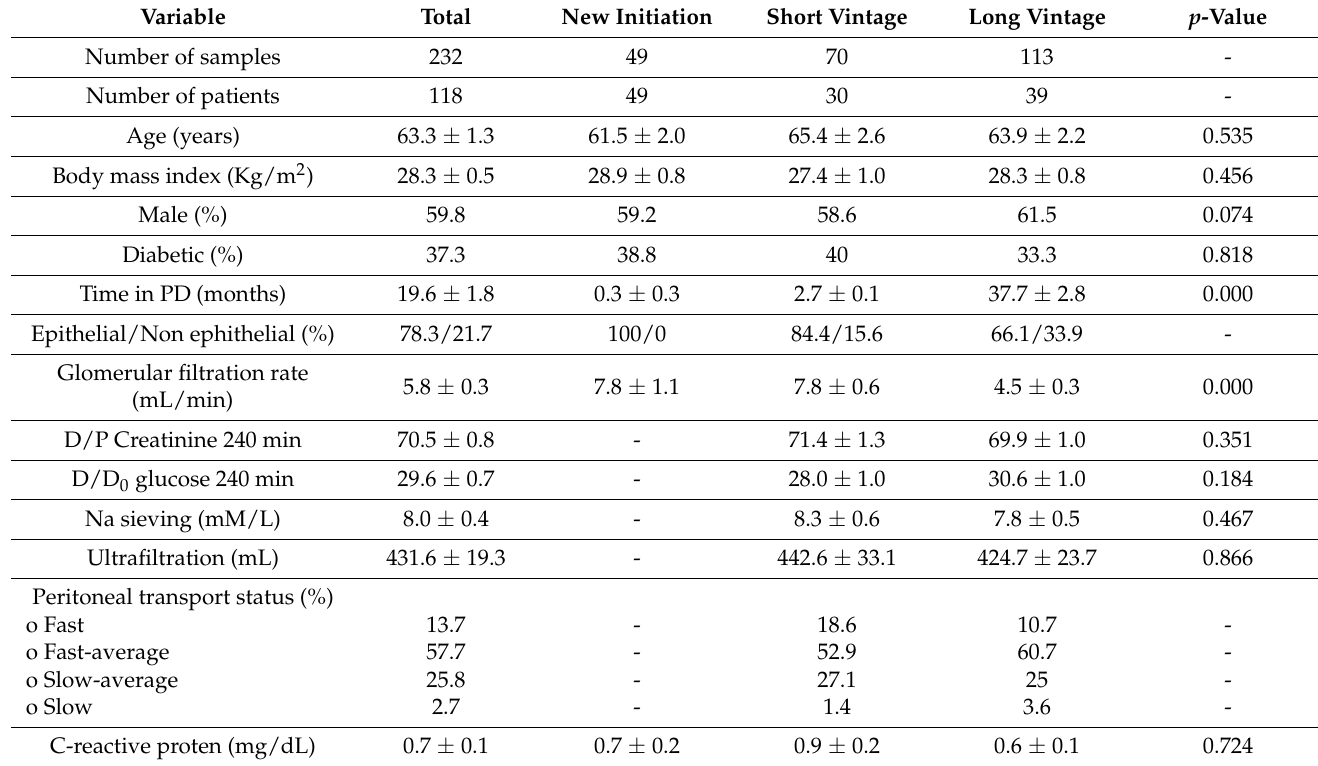
Table 2. Demographic and clinical characteristics of patients classified according to time on PD in new initiation, short vintage and long vintage samples.